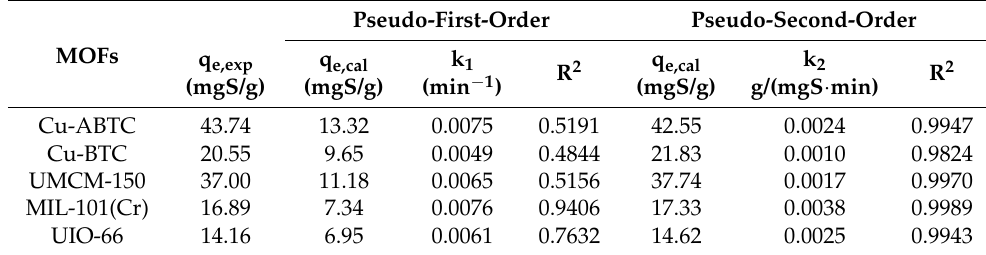
Table 2. Parameters of the kinetic